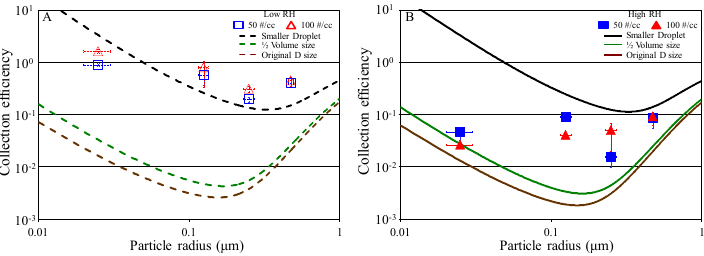
Figure 10. CE as a function of particle radius at low and high RH ( a and b , respectively). CE experimentally determined in this study (points) with theoretical calculations (lines). The lines represent calculation with different droplet sizes: the measured droplet size (brown), droplets with half the volume (green) and 5µm droplets (black). See text for details.